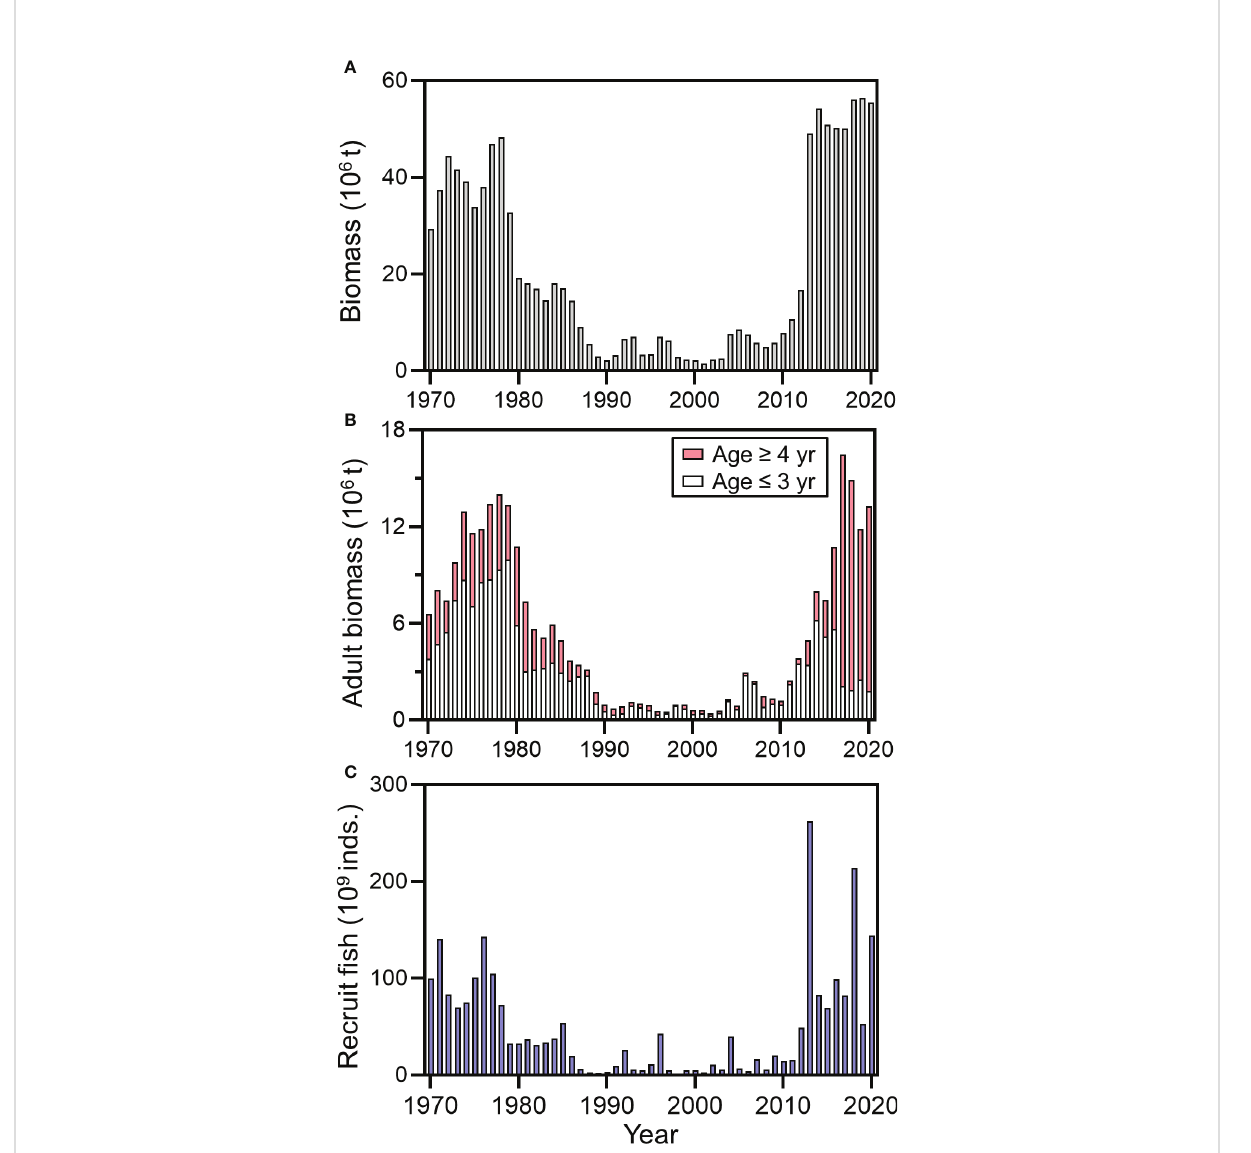
FIGURE 1 Total biomass (A) , adult biomass (B) , and number of recruit fi sh (C) of the Paci fi c stock of chub mackerel during 1970 – 2020 (after Yukami et al. (2021)). Adult biomass at age ≤ 3 and ≥ 4 years are also shown (B) . Most females of age ≥ 4 years were considered repeat spawners that had spawned at least once in their